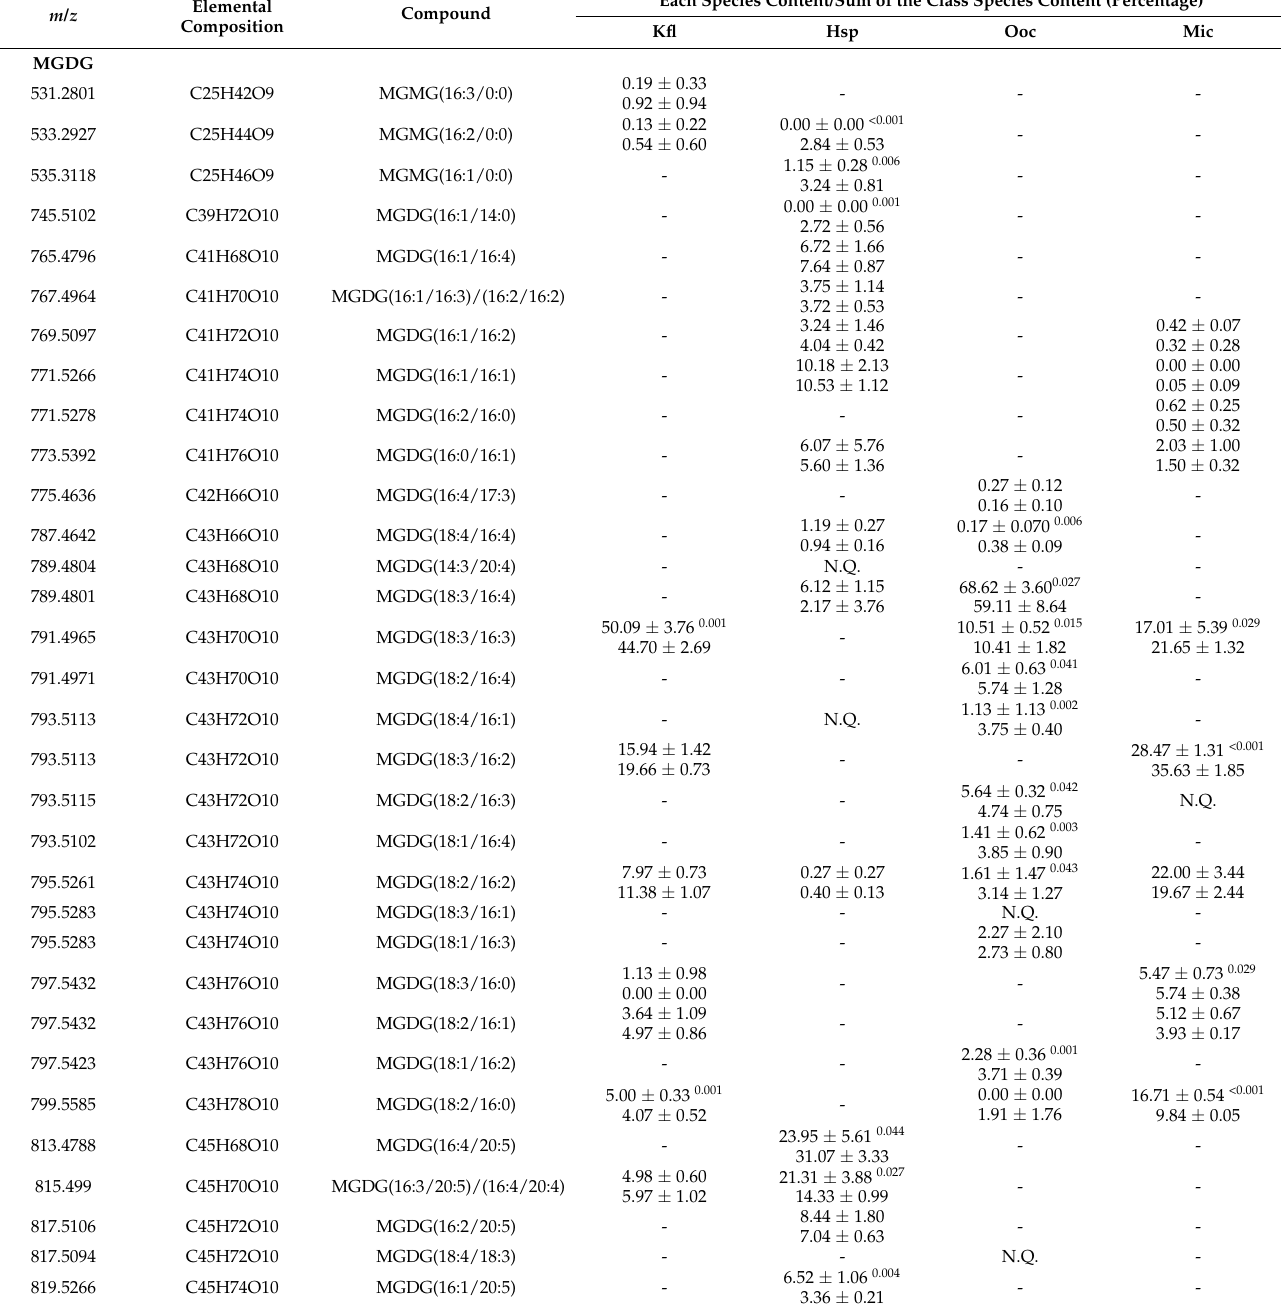
Table 2. Glycerolipid species detected in the algal and cyanobacterial extracts. The averaged percentages of a given glycerolipid species within the corresponding glycerolipid class and of a given class with regard to the total glycerolipid ( ∑ GLs = MGDG + DGDG + SQDG + PG) content are provided ( n = 3). Upper and lower values correspond to the low and high light conditions, respectively. Nomenclature: MGDG, monogalactosyldiacylglycerol; DGDG, digalactosyldiacylglyc- erol; SQDG, sulfoquinovosyldiacylglycerol; PG, diacylglycerylphosphoglycerol; PC, diacylglycerylphosphocholine; PE, diacylglycerylphosphoethanolamine. Abbreviations: Kfl, Klebsormidium flaccidum ; Hsp, Haslea spicula ; Ooc, Oocystis sp.; Mic, Microcoleus vaginatus . The p -value of the Student t -test for the comparison between high light and low light data is indicated as a superscript for values <0.05. Species marked with the symbol § superscript could not be accurately identified. N.Q. = not